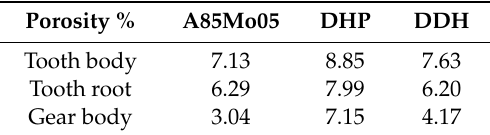
Table 4. Mean porosity values in di ff erent regions of the gear measured using image analysis on metallographic sections. Table taken from